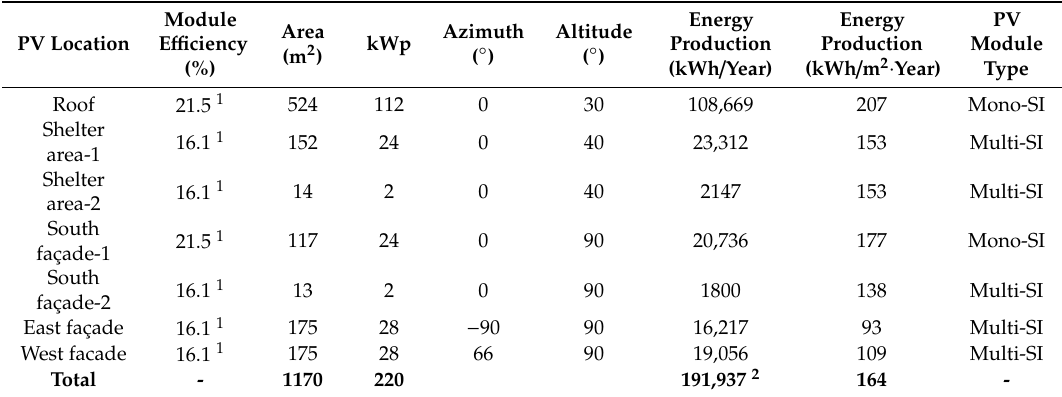
Table 1. Main characteristics of the building integrated photovoltaic panel (BIPV) installed on the zero-emission building (ZEB)